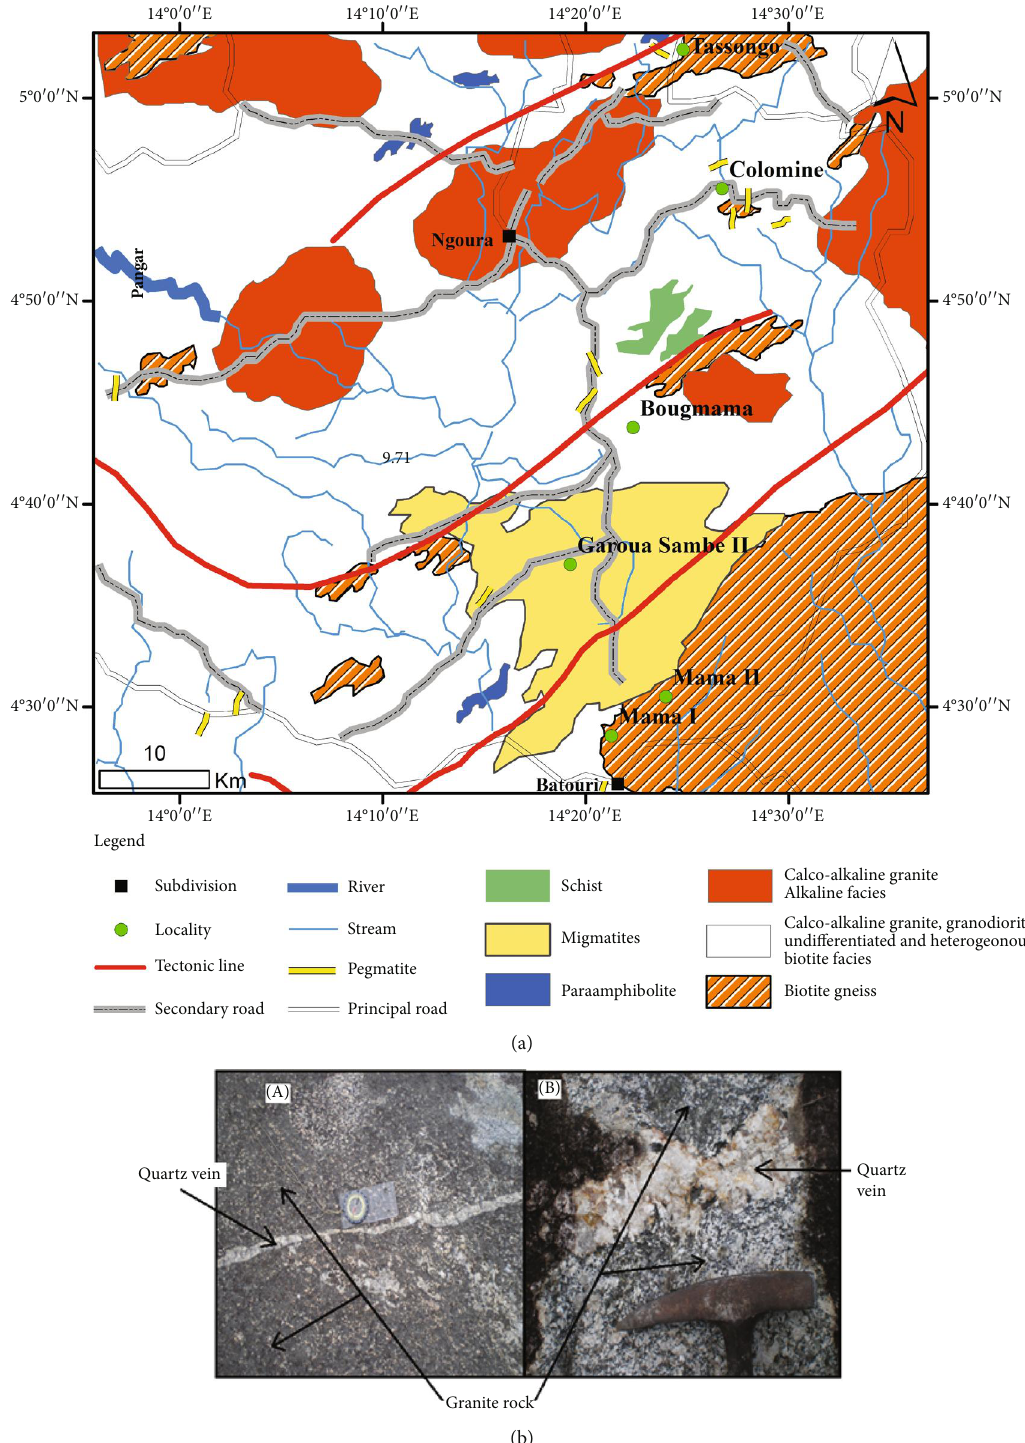
Figure 2: (a) Geological map of the study area [13]. (b) Outcrops of quartz vein (A) and granite rock (B) observed in the study